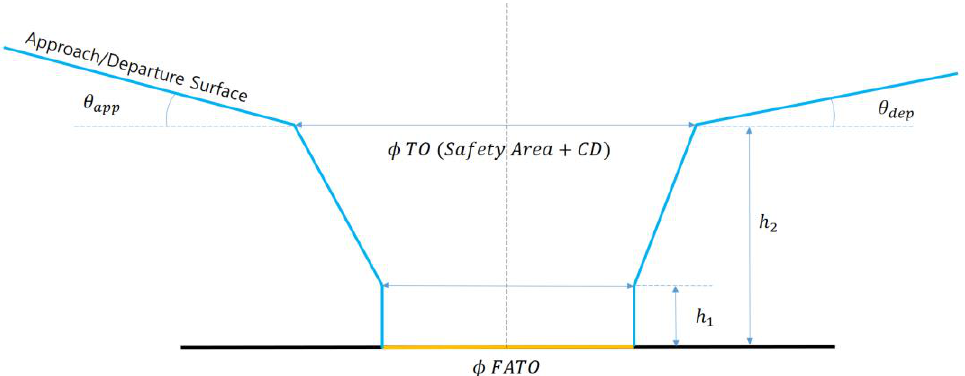
Figure 8. Dimensions of an omnidirectional obstacle-free